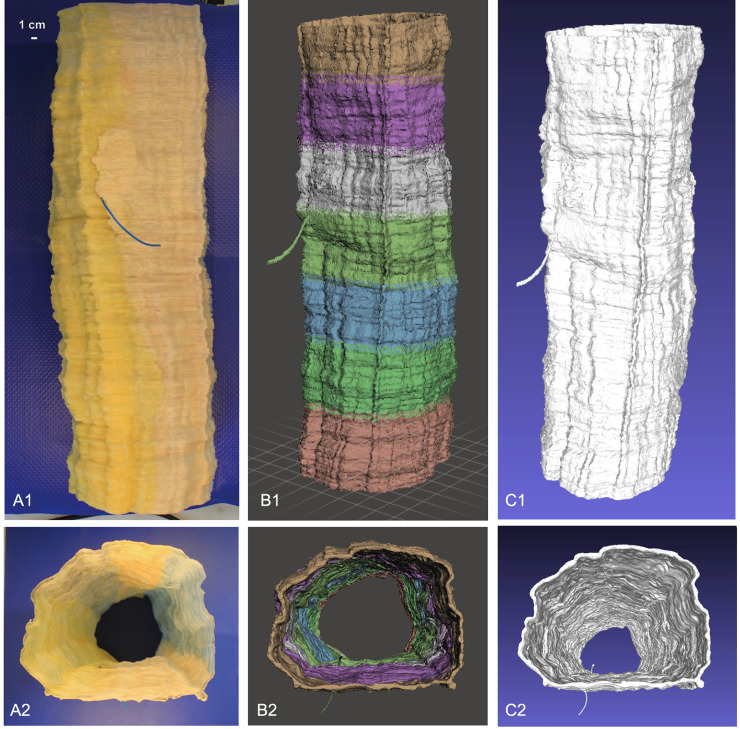
Sequential steps from the TEM-based wax model reconstruction to the DICOM files acquisition and consequential 3D digital model editing (A1-A2, B1-B2, C1-C2). A1-A2: lateral and top (lumen) view of the wax 3D model of the lymphatic vessel; the blue electric wire crossing the channel shows the intravasation path of a TCi. B1-B2: lateral and top (lumen) view of the digital reconstruction of the wax 3D model of the lymphatic vessel highlighting the seven CT scan acquisition windows. The result was exported in DICOM files to perform the segmentation process and obtain the virtual digital vessel model. C1-C2: lateral and top (lumen) view of the digital black/white reconstruction of the TEM-based wax 3D model of the lymphatic vessel. CT: computed tomography; DICOM: Digital Imaging and Communication in Medicine; TEM: transmission electron microscopy.